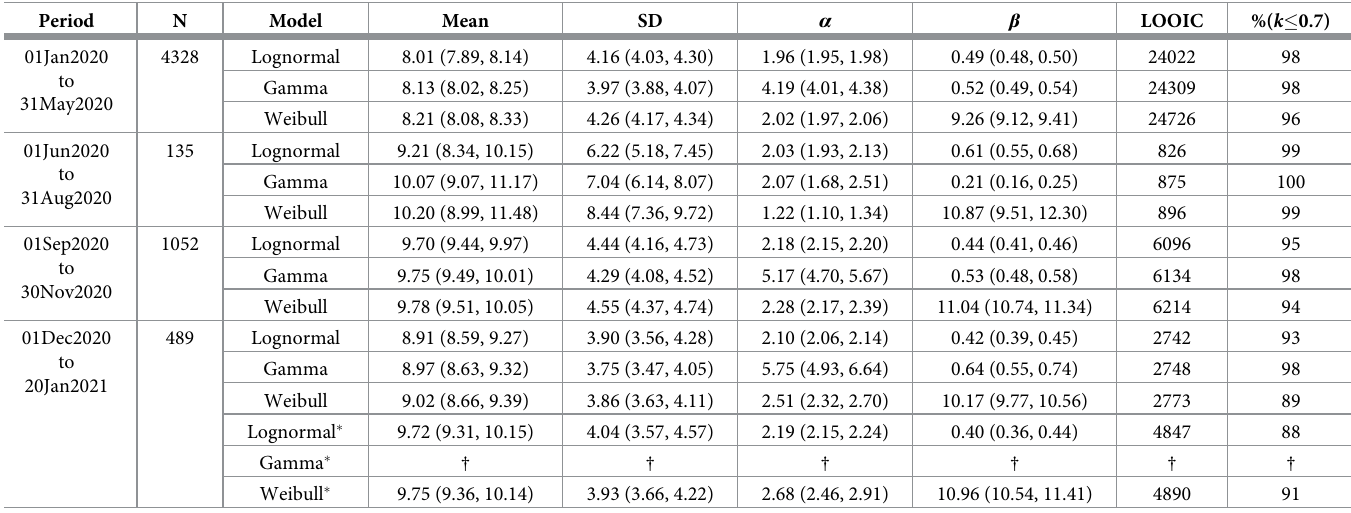
For the last time period from 1 December 2020 to 20 January 2021, the right truncated model was run as well. 90% credible intervals are quoted � Model run with right truncation using r = 0.0173.